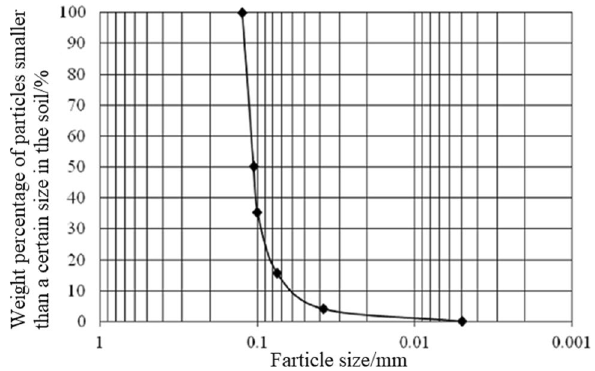
Figure 2. Sediment particle curve.